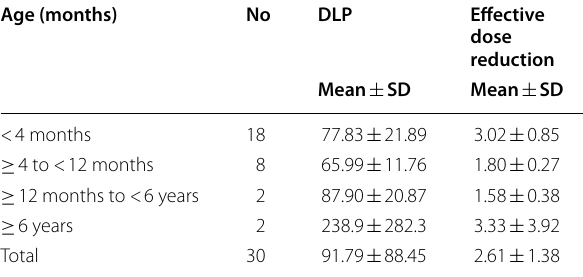
Table 9 Descriptive analysis of the studied cases according to DLP and effective dose reduction in each age